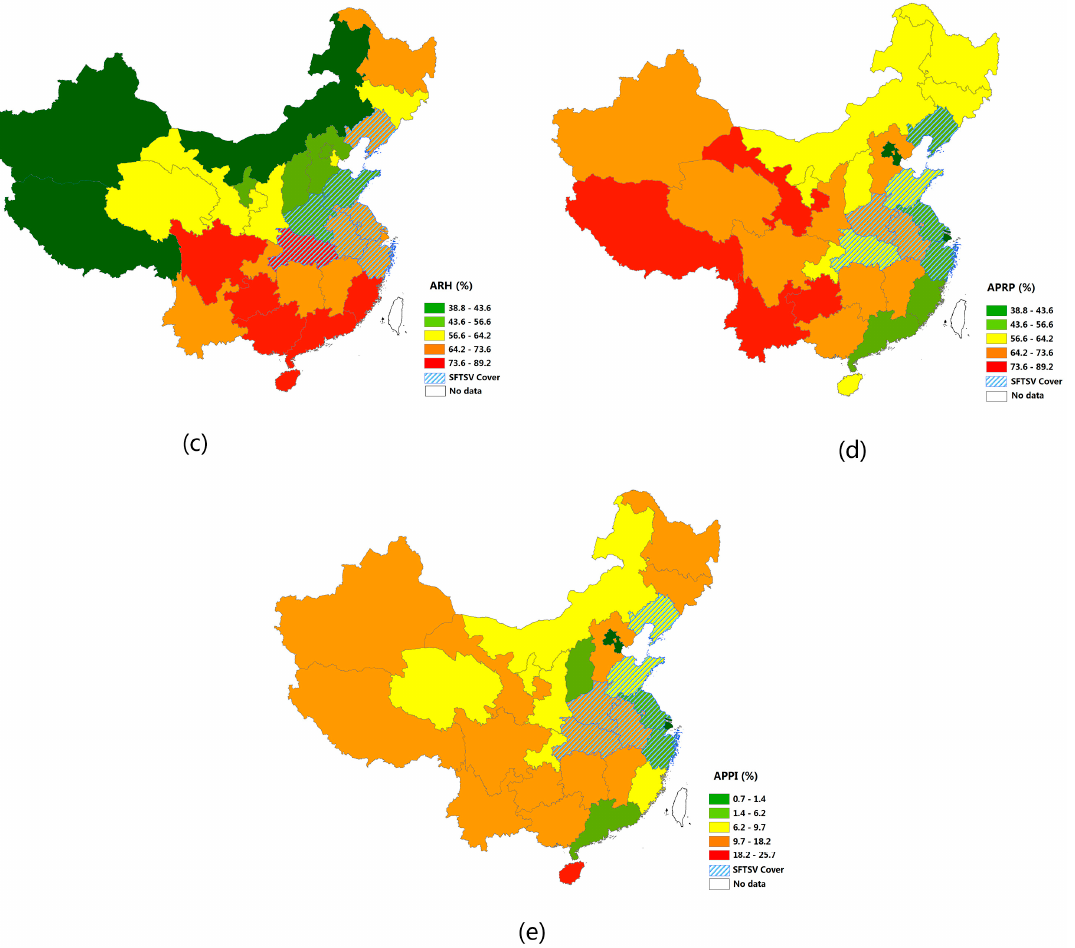
Figure 3. Spatial distribution of the five potential determinants of SFTSV cover: ( a ) Average temperature (AT) from 2010 to 2012; ( b ) Average monthly precipitation (AMP) from 2010 to 2012; ( c ) Average relative humidity (ARH) from 2010 to 2012; ( d ) Average proportion of rural population (APRP) from 2010 to 2012; and ( e ) Average proportion of primary industries (APPI) from 2010 to 2012.